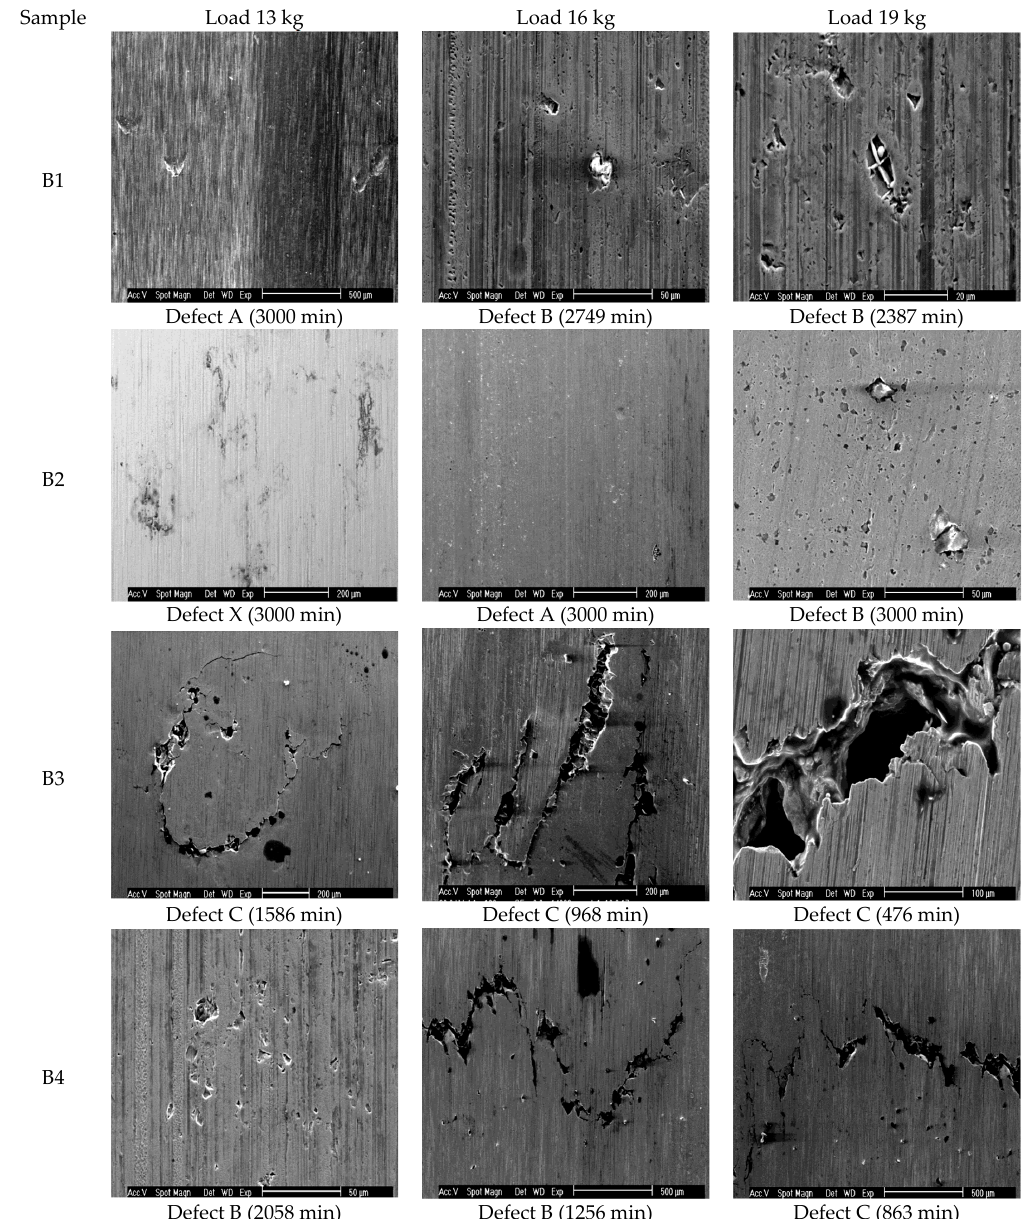
Figure 9. Surface of clad layers after rolling fatigue.